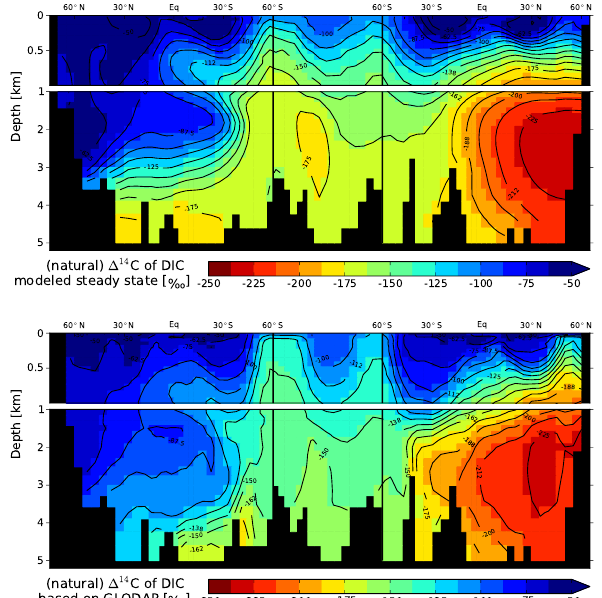
(natural) ∆ 14 C of DIC modeled steady state [ ]